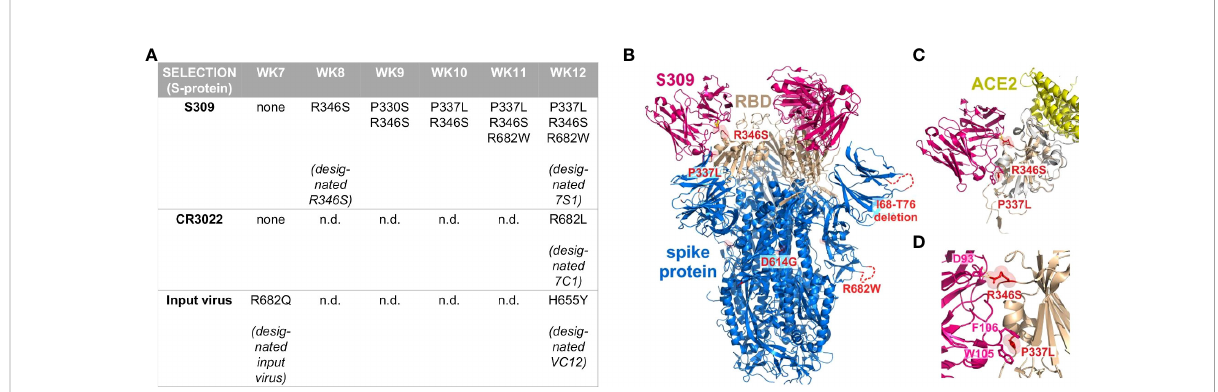
FIGURE 2 Characterization of de novo SARS-CoV-2 spike amino acid exchanges in the course of S309 selection. (A) Next generation sequencing of cell culture supernatants from weeks (WK) 7-12 of the antibody selection. The table displays spike protein amino acid exchanges that emerged over time, using the sequence of the input virus as reference (GenBank accession no. ON715117). Sequences of 7S1 (ON003597), 7C1 (ON630346), and VC12 (ON630347) were also deposited at GenBank. (B) Projection of de novo amino acid exchanges R346S, P337L, and R682W onto the SARS-CoV-2 spike protein trimer (blue) in complex with the neutralizing antibody S309 (pink) at 3.10 Å resolution. The dashed lines show a non- resolved amino acid stretch of the SARS-CoV-2 spike protein including a deletion at positions 68 to 76 ( D I68- D T76), which was already present in the input virus (C, D). Close-up views of amino acid exchanges R346S and P337L, which did not interfere with ACE2 (yellow) binding to the receptor-binding domain (wheat), but impaired the interaction of the receptor-binding domain with S309. Structures were visualized based on Protein Data Bank entries 6WPS and 6M17. Protein structures were visualized using Pymol (version 2.5.2, LLC